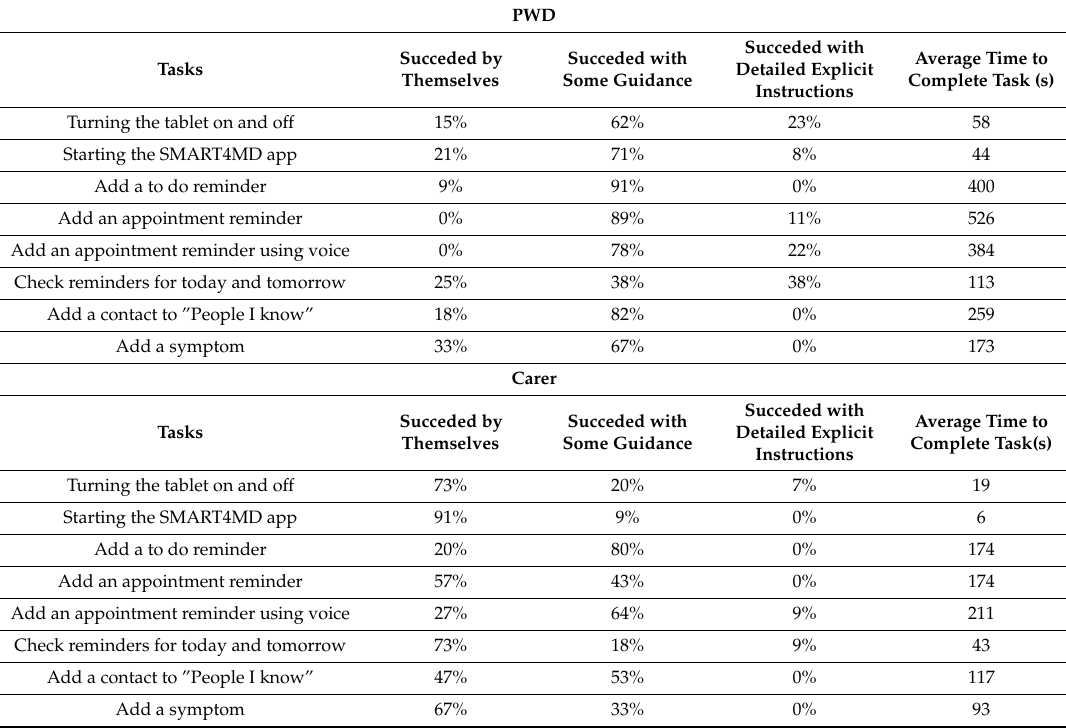
Table 2. User performance of task included in the usability-feasibility testing.